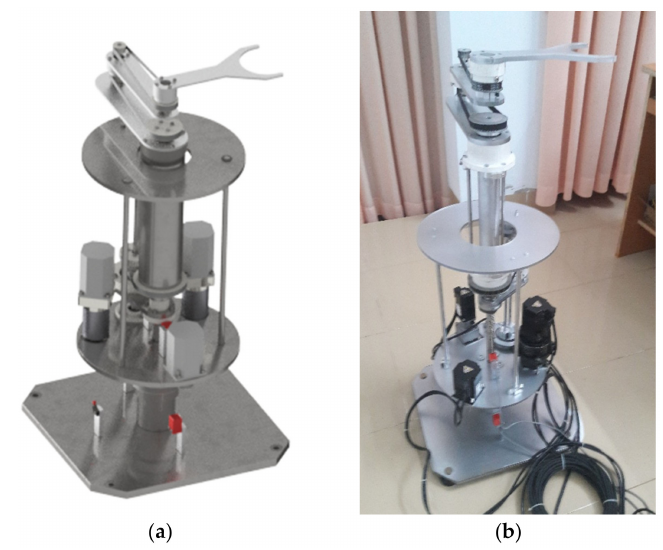
Figure 21. Result of the design in the computer ( a ) and the experiment ( b ).